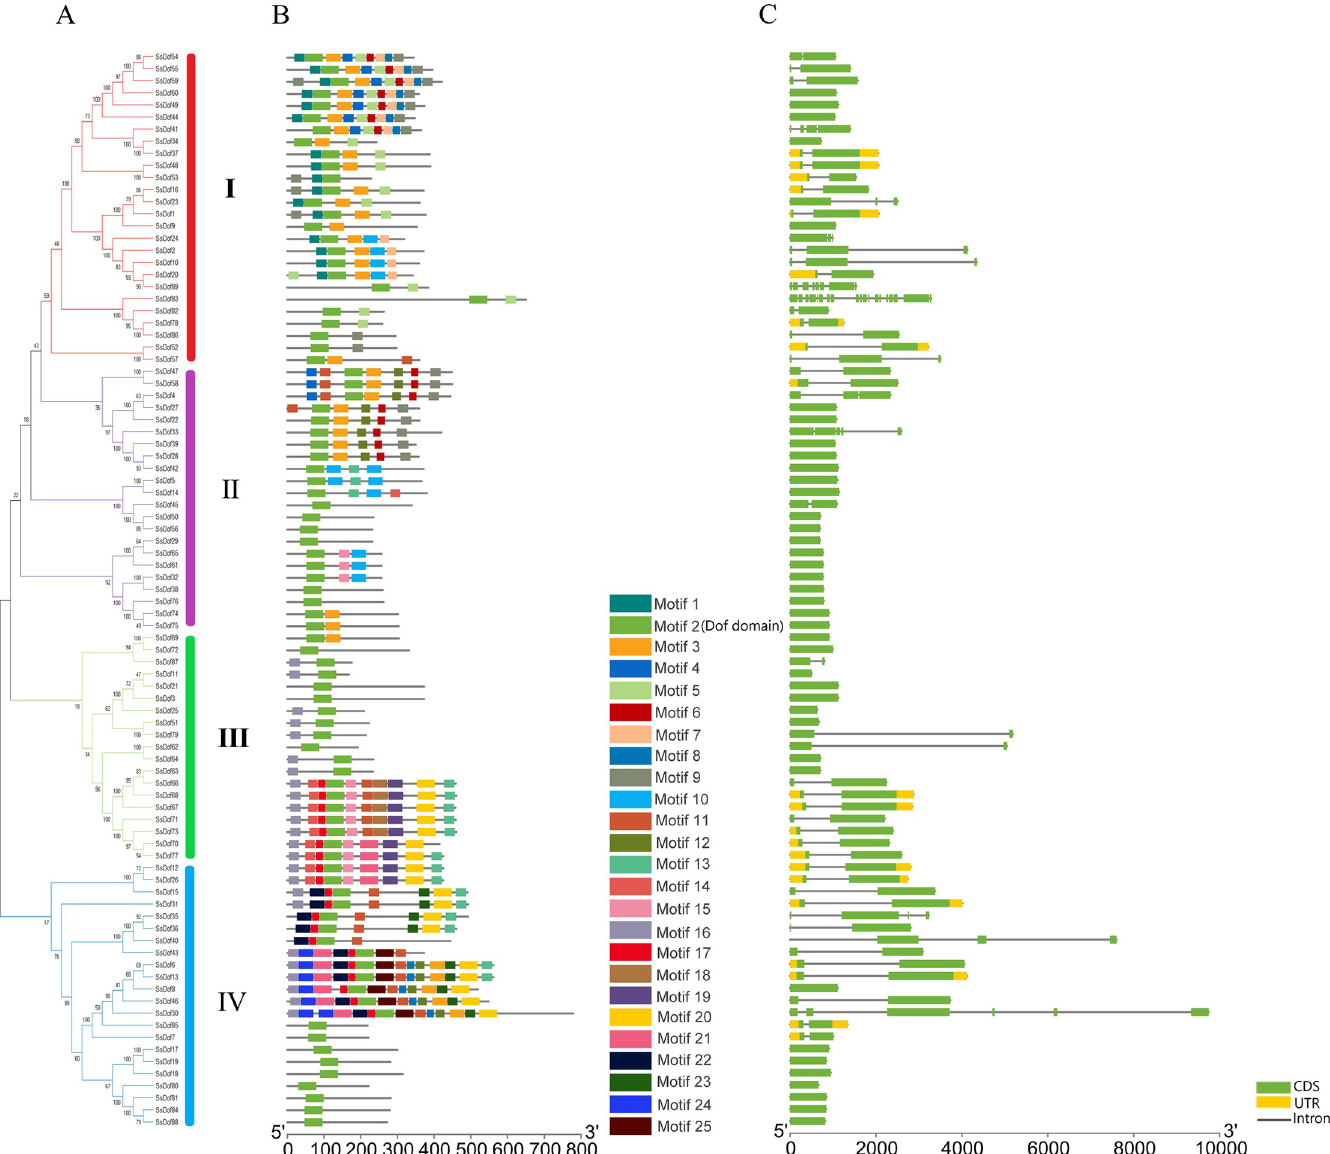
Fig 3. Phylogenetic relationship, conserved protein motifs and gene structures of SsDof genes in sugarcane. (A) The phylogenetic tree was based on multiple sequence alignments of SsDof proteins using MEGA 5 and divided into four groups ( Ⅰ , Ⅱ , Ⅲ and Ⅳ ). (B) The conserved motif of SsDof proteins. The motifs are shown in different color boxes with numbers 1–25. (C) The gene structures of SsDof genes. The green boxes indicate CDS; the yellow boxes indicate untranslated 5 0 - and 3 0 - regions; the black lines indicate introns.